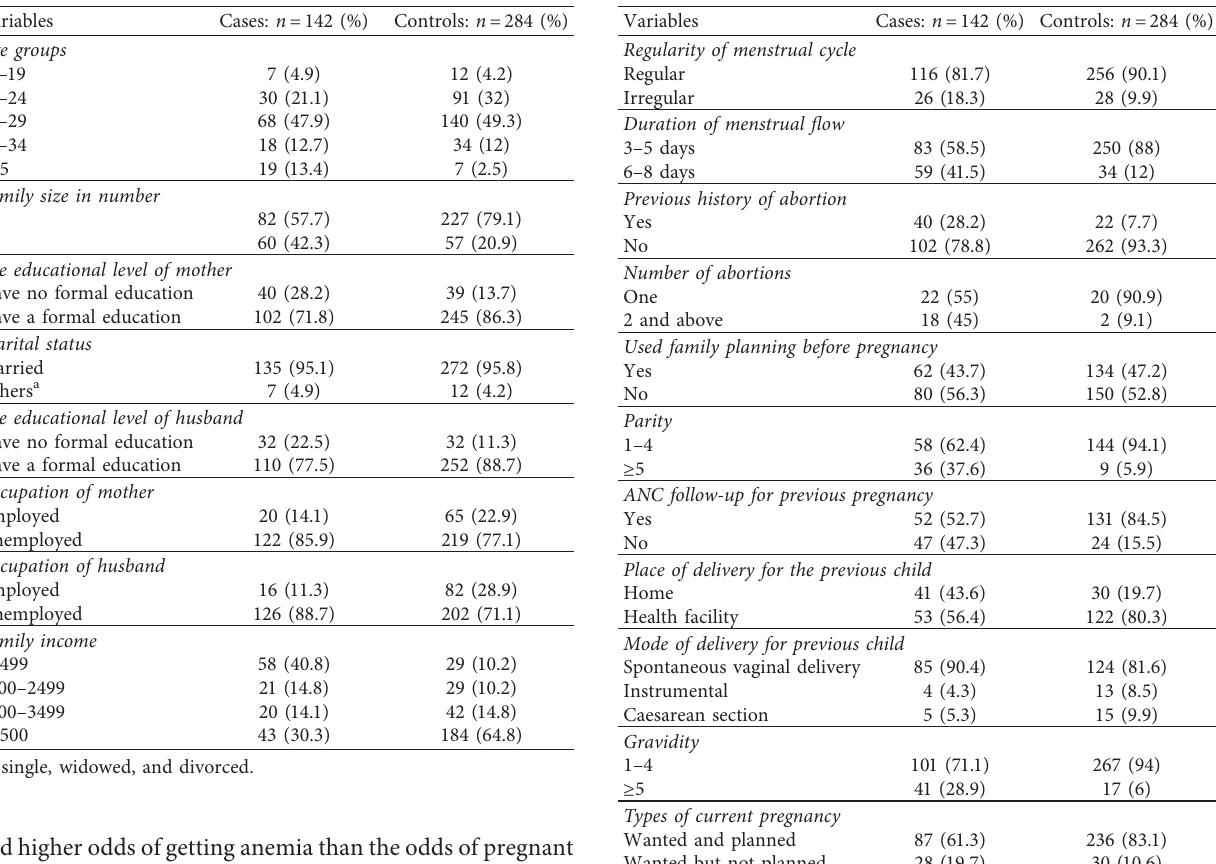
Table 2: Obstetrics and gynecology-related characteristics of pregnant women attending ANC in public hospitals of the West Shewa zone, from February to April 2019.